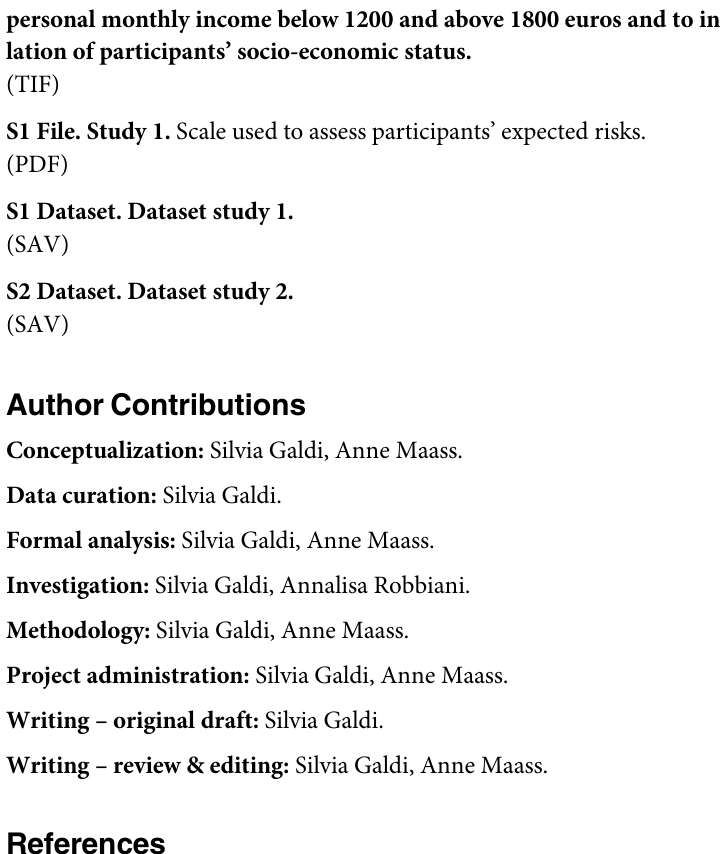
S1 Fig. Scales used in study 1 and study 2 to exclude from the sample participants with a personal monthly income below 1200 and above 1800 euros and to introduce the manipu- lation of participants’ socio-economic